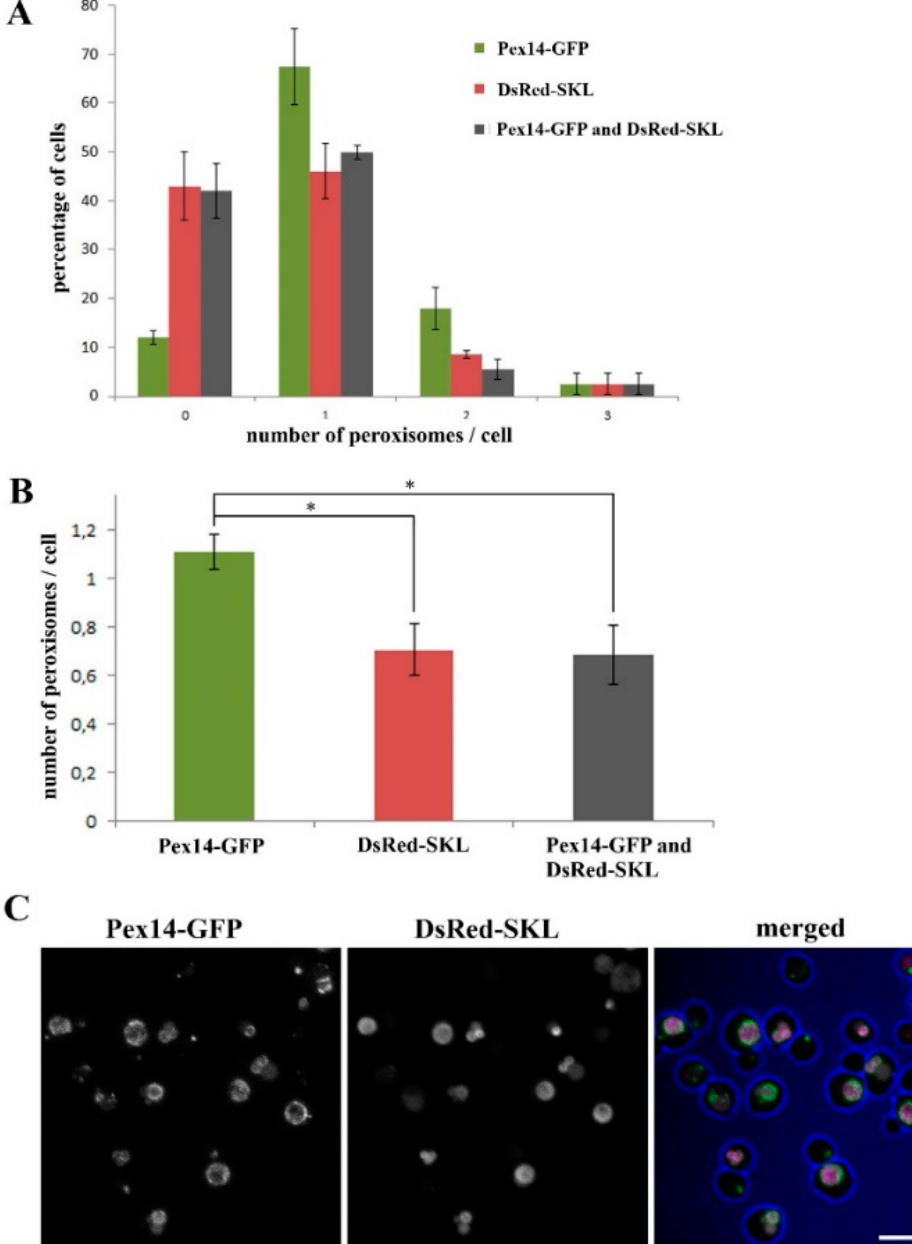
Figure 1. Almost all H. polymorpha pex11 cells possess at least one peroxisome. ( A ) Frequency distributions of fluorescent spots in H. polymorpha pex11 cells. Fluorescent structures were quantified using the indicated peroxisomal fluorescent markers. Cells were grown for 16 h on methanol containing medium. Data were obtained from two independent experiments ( n = 2). In each experiment peroxisomes were counted in 100 cells, including buds with a diameter comprising at least 1 / 3 of corresponding mother cell’s diameter. The error bars represent the standard deviation. ( B ) Comparison of the average number of peroxisomes per cell detected in pex11 cells using different fluorescent protein markers. More peroxisomes are detected when solely Pex14-GFP is used as a peroxisome marker (* p < 0.05). Cells were grown as indicated in Figure 1A. ( C ) Example of confocal laser scanning microscopy (CLSM) image representing pex11 cells used for the quantification shown in ( A ) and ( B ). Blue represents cell edges. The scale bar represents 10 µm.